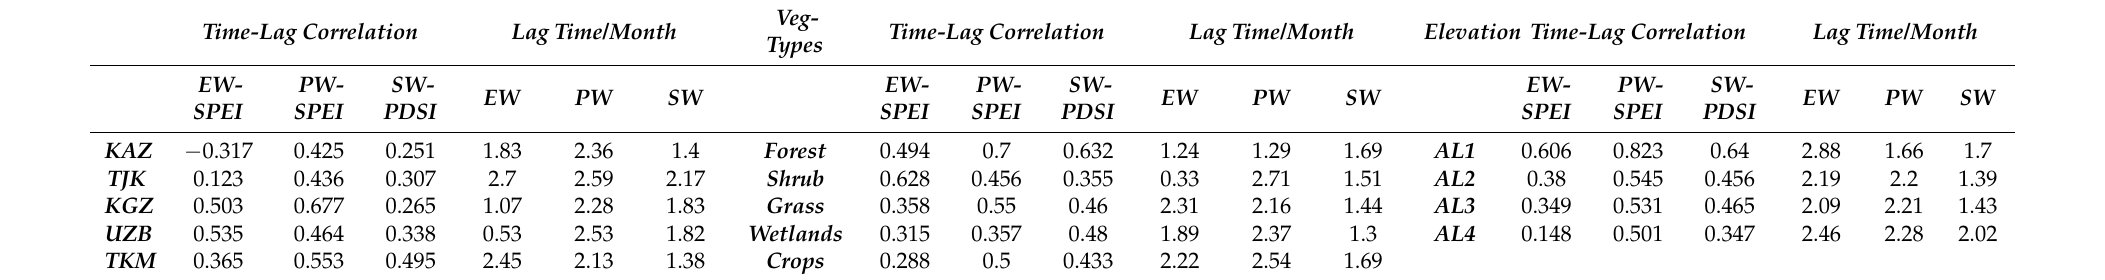
Table 3. Time-delay Correlation Coefficient and Time Lag of WUE Response to Drought in Central